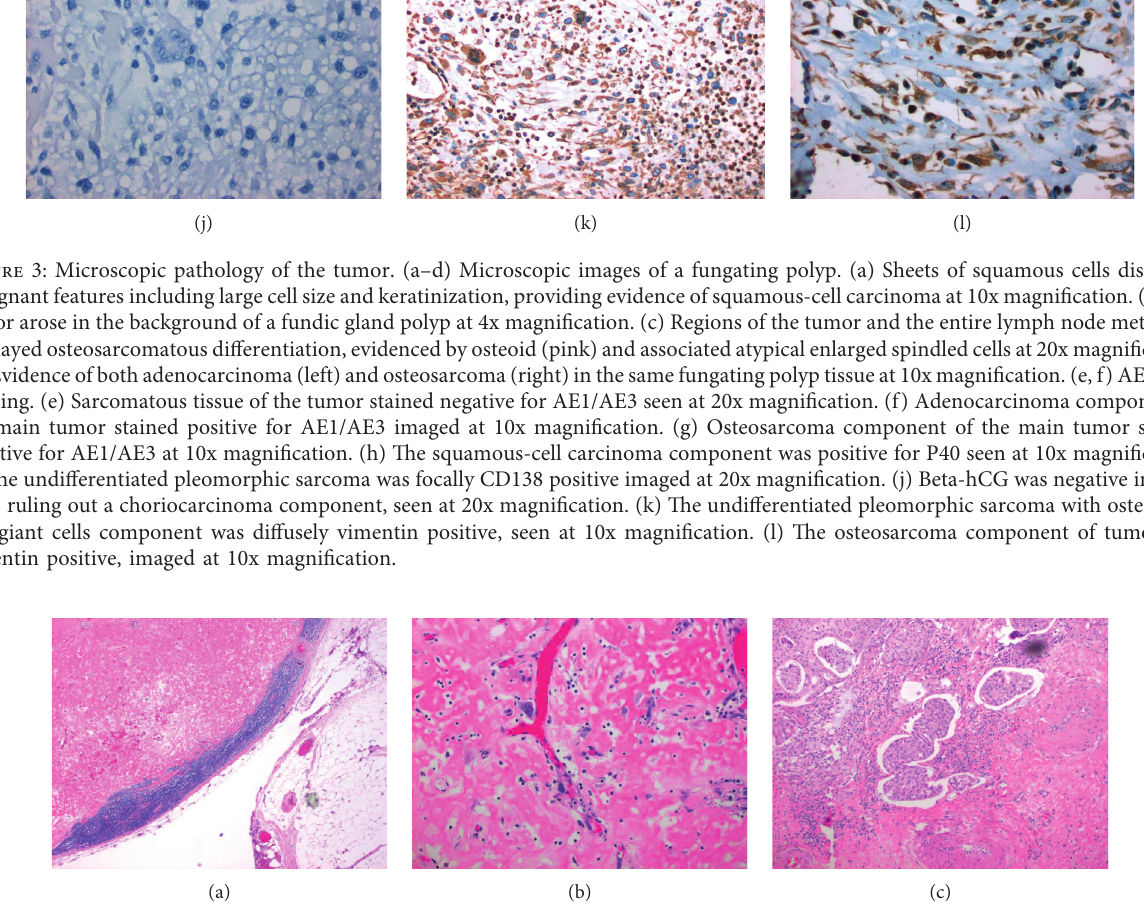
Figure 4: Evidence of lymph node metastasis. (a) Osteoid (pink) from osteosarcoma metastasis seen in a lymph node at low power (4x). Note the blue lymphoid cuff on the rim of the lymph node just under the capsule, identifying it as a largely replaced lymph node. (b) Osteoid and atypical spindled cells from osteosarcoma were found in a distant lymph node (higher power of (a) at 20x magnification). (c) Squamous lymphovascular invasion in the main tumor at 10x magnification. Squamous-cell tumor plugs displayed invasion in the lymphatic